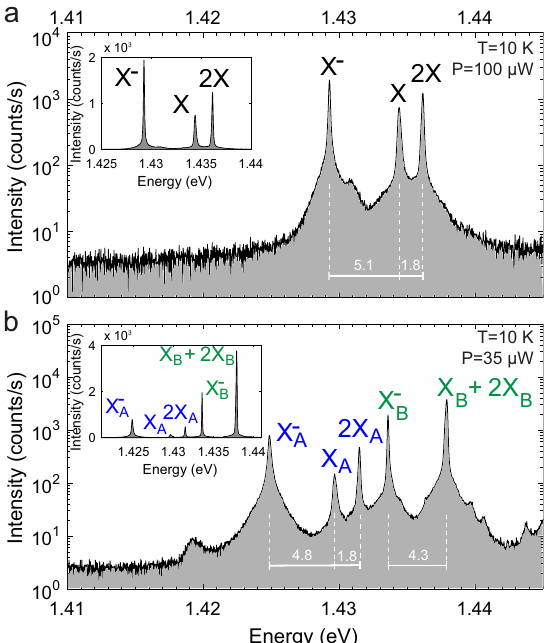
Figure 2. Comparison of PL semilogarithmic spectra of pyramidal QDs in off-resonance PhC L 3 cavities. ( a ) Typical off-resonant spectrum of a single QD at low excitation. ( b ) Two QDs with corresponding spectral lines labeled A and B. The neutral exciton X B and the bi-exciton 2 X B lines overlap in the case of QD B . Separations of spectral features are indicated in meV . Insets: Corresponding linear scale